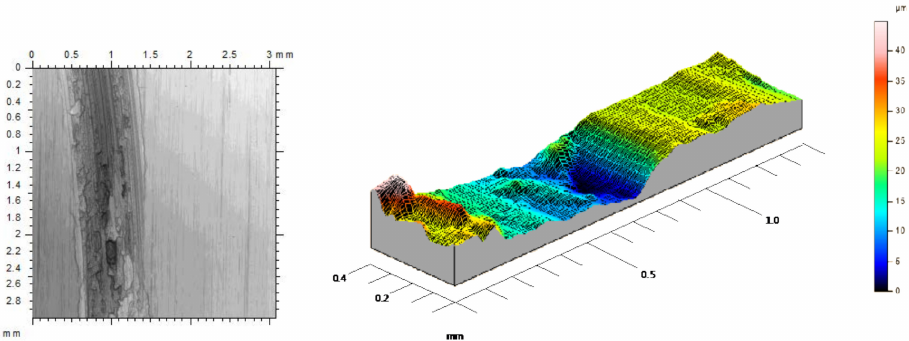
Figure 4. First stage sliding track with abrasive wear effects.